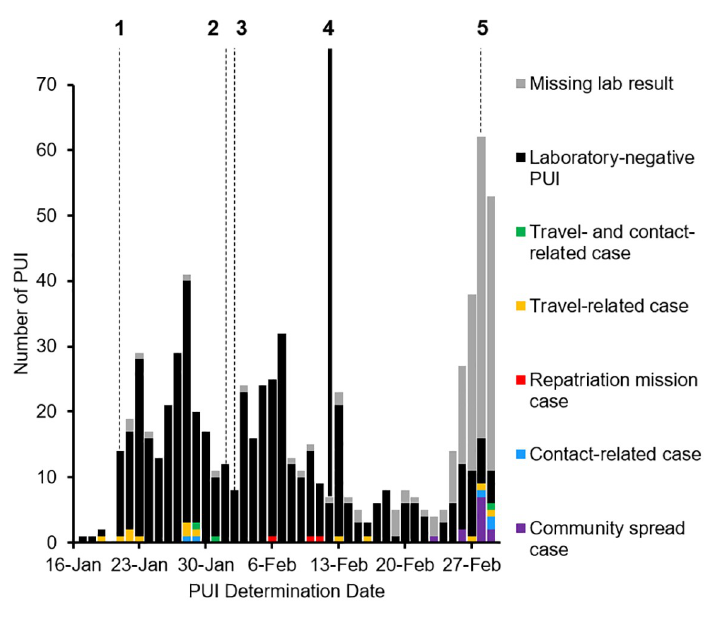
Fig 1. Epidemiologic curve of persons under investigation for COVID-19: Frequency by determination date, SARS-CoV-2 test status, and COVID-19 case type, United States, January 17–February 29, 2020 ( N = 711). 1: CDC activates the Emergency Operations Center. 2: WHO declares COVID-19 outbreak a public health emergency of international concern, and persons under investigation (PUI) evaluation criteria change to expand the travel-related epidemiologic exposure criterion (Table 1). 3: The United States introduces travel restrictions for foreign nationals with travel from China in the last 14 days. 4: PUI evaluation criteria changed to include a criterion for testing of persons with severe unexplained respiratory illness by addition of a footnote. 5: PUI evaluation criteria changed to expand the travel-related exposure criterion to include any geographic area affected by COVID-19, and the criterion for patients with severe unexplained respiratory illness, regardless of epidemiologic exposures, was moved into the main body of the PUI evaluation criteria. “Missing” = testing was performed locally and a result was not communicated to CDC, or inconsistent or missing information in linking variables did not allow for matching between CDC laboratory and epidemiologic databases. Community spread cases had no known travel- or contact- related